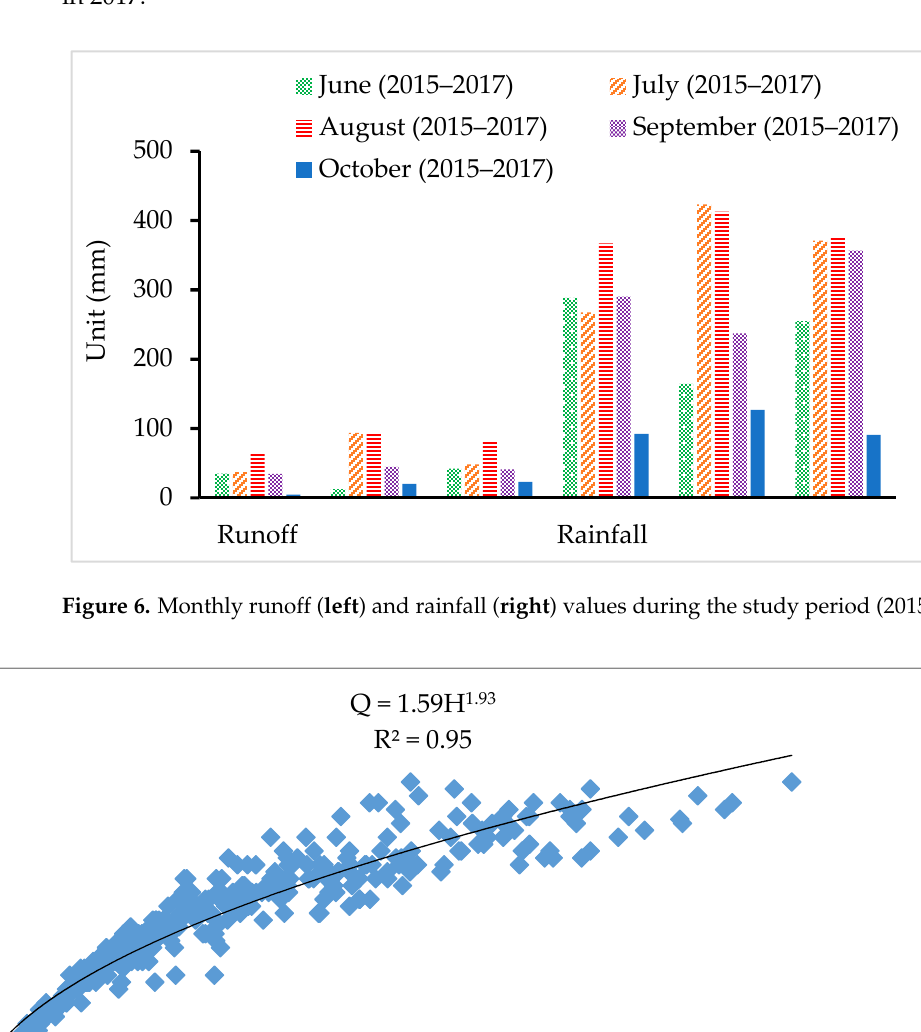
Figure 5. Monthly shallow groundwater recharges (2015 to 2017) for all monitoring wells. The values of recharge indicated were for the specific monitoring wells (point value).